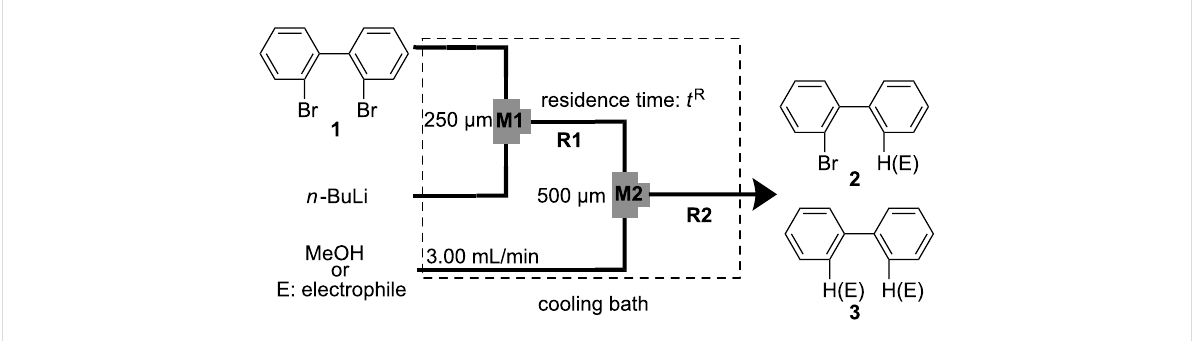
Figure 1: Microflow system for Br-Li exchange reaction of 2,2′-dibromobiphenyl ( 1 ). T-shaped micromixer: M1 (ø = 250 μm) and M2 (ø = 500 μm), microtube reactor: R1 and R2 (ø = 1000 μm, l = 50 cm), a solution of 2,2′-dibromobiphenyl ( 1 ): 0.10 M in THF, a solution of n -BuLi: 0.50 M in hexane, a solution of electrophile: 0.30 M in THF.